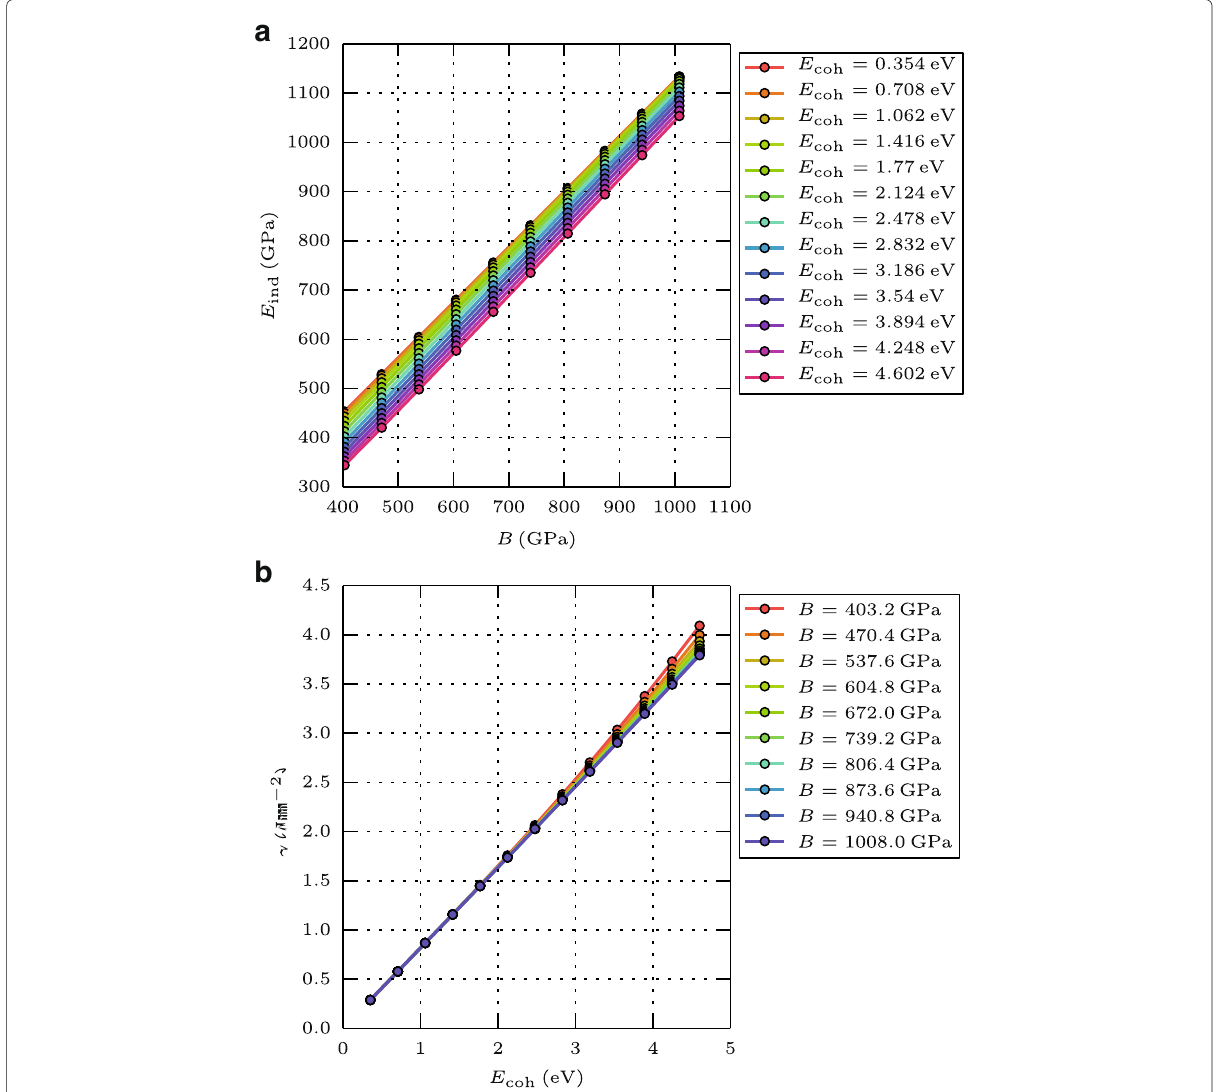
Fig. 1 Materials parameters. Dependence of a the indentation modulus E ind on the bulk modulus B and of b the surface energy γ on the cohesive energy